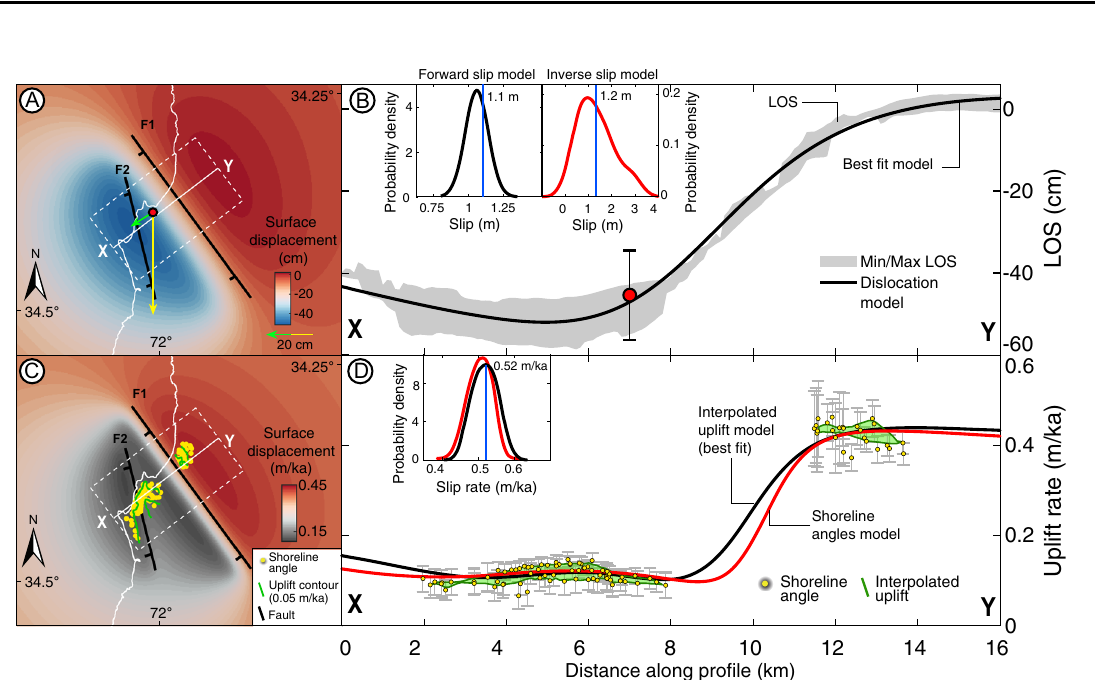
Fig. 4 Coseismic and long-term fault-slip models. A Best- fi t model forward of Line of Sight (LOS) displacements as a result of the 2010 PIF earthquakes, green and yellow arrows denote horizontal and vertical displacements, respectively, estimated at continuous GPS station PICH 34 . B Swath pro fi le showing Envisat ® LOS displacements and best- fi t forward model. Red dot shows PICH displacement projected to Envisat LOS. Insets in B are the probability-density distributions of coseismic slip of the forward (black line) and inverse (red line) models (See Figs. S10 and S11), blue lines denote best- fi t slip and median slip of both models, respectively. C Best- fi t dislocation model based on interpolated marine terrace uplift rates (yellow dots denote measurement locations). D Swath pro fi le comparing fault-slip model based on shoreline angles (red line) with a model based on interpolated uplift rates from shoreline angles (black line). Insets show probability-density distributions of slip rate values used to estimate con fi dence interval (See Fig. S10). The green polygons in D are the interpolated uplift rate surfaces projected along the pro fi